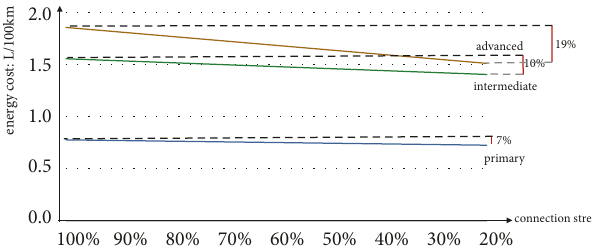
Figure 5: Fuel consumption cost of intelligent vehicle under different connection strength.